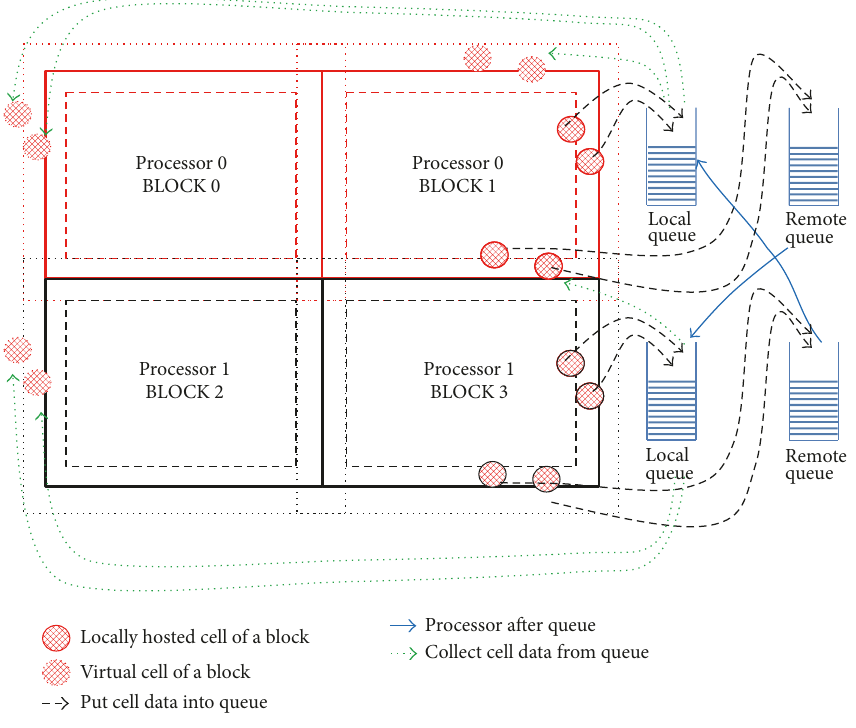
Figure 1: Schematic for parallelization of the solid solver for